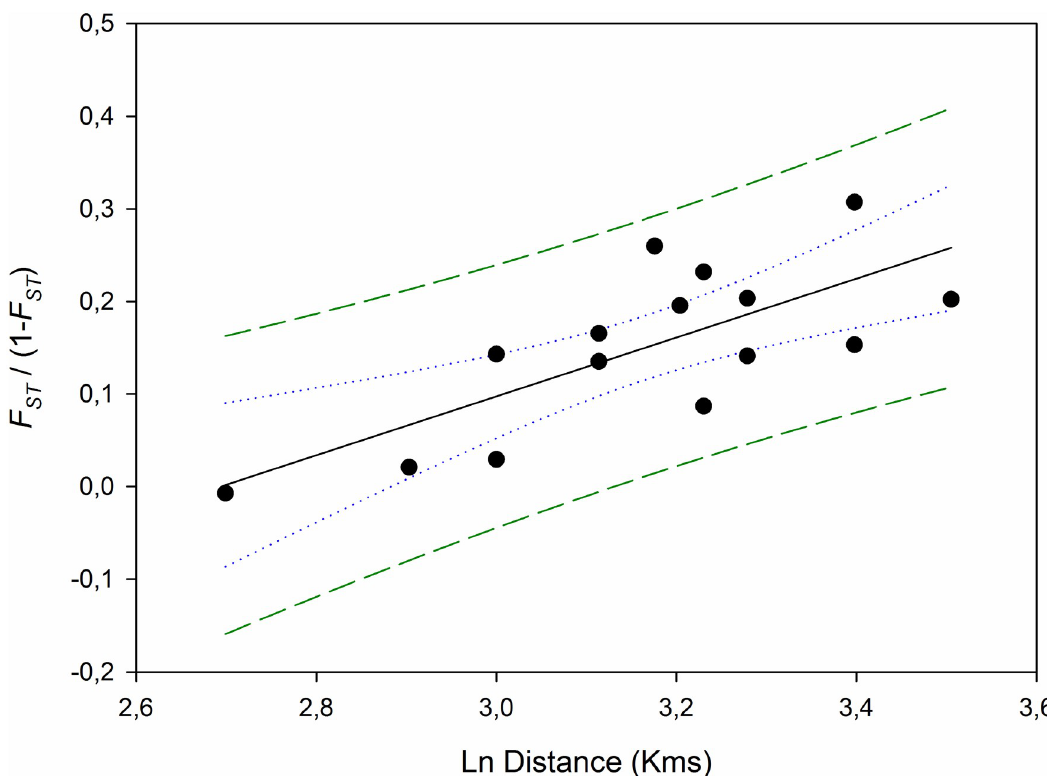
Fig 4. Regression analysis of linearized F ST values and geographic distance among Octopus vulgaris ( R 2 = 0.5482, P = 0.0016). Lines depict the 95% confidence (blue-dots) and 95% prediction (green dashes) bands.